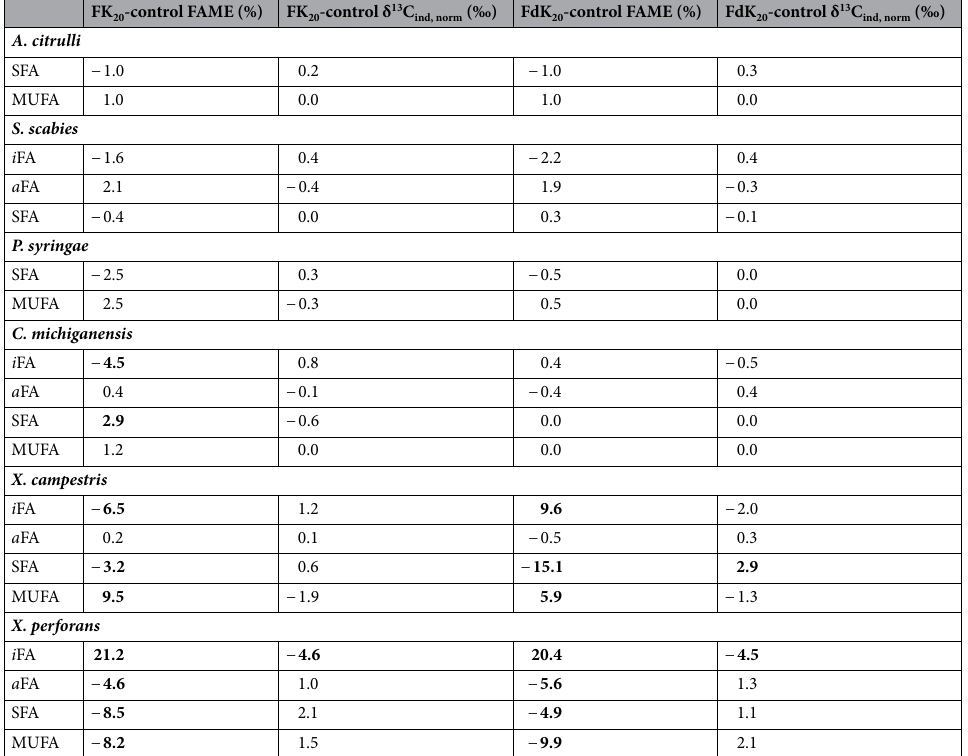
Table 4. Differences in the percentage distribution (%) and the δ 13 C ind, norm values (‰) of the fatty acid groups determined with GC-C-IRMS between the FK 20 - or FdK 20 - treated samples and the untreated control sample. Significant values are in [bold]. With SFA Saturated fatty acids, MUFA Monounsaturated fatty acids, iFA iso - fatty acids, aFA anteiso -fatty